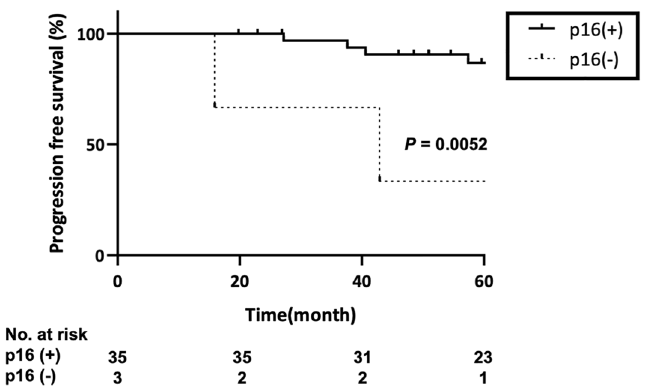
Figure 3. Kaplan–Meier analysis of p16 expression and progression-free survival in 38 patients receiving CCRT. Patients with p16 overexpression are indicated with a straight line and those without p16 expression with a dashed line. CCRT, Concurrent chemoradiation